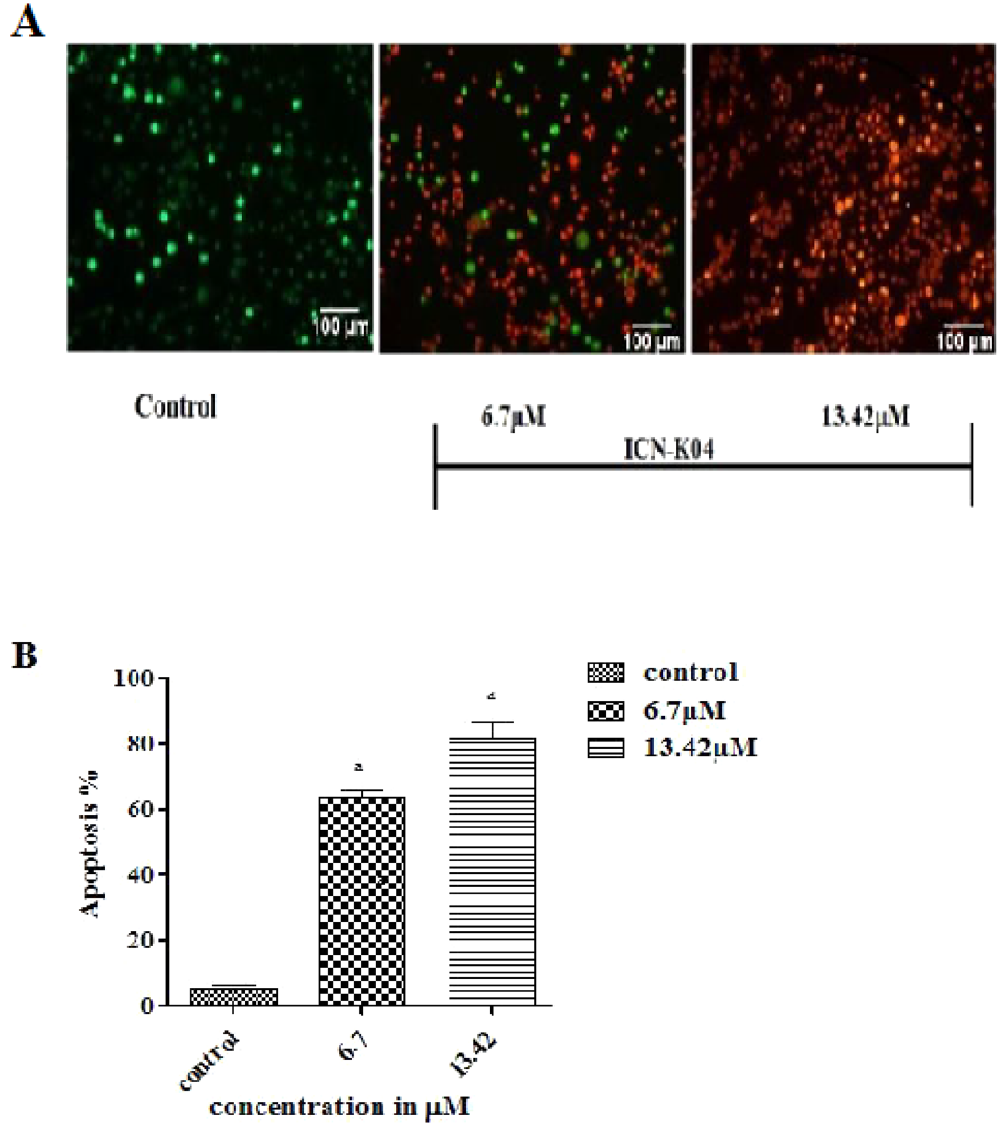
Figure 10. Apoptotic effect of ICN-K04. ( A ) Photomicrograph showing the effect of ICN-K04 induced apoptotic morphological changes in A549 cells. ( B ) Changes in fluorescent intensity after treatment with ICN- K04 in A549 cells as compared to control cells after 24 h. Values are expressed as Mean ± SEM. P < 0.05